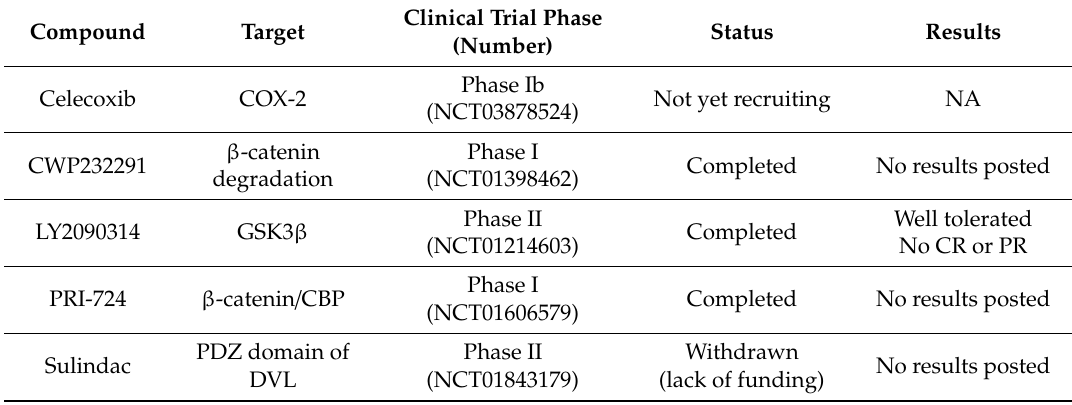
Table 3. Clinical trials involving Wnt signalling inhibitory / modulating